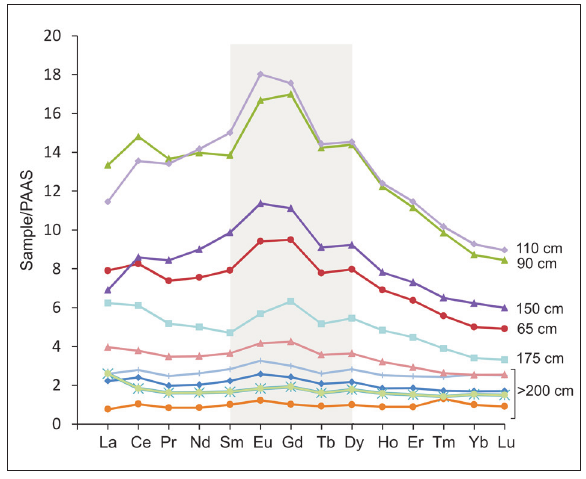
Figure 7: Post-Archaean Australian Shale (PAAS)-normalised rare earth element (REE) patterns of peat samples from Site L. Note that samples from 65 cm to 175 cm show significant medium REE enrichment.